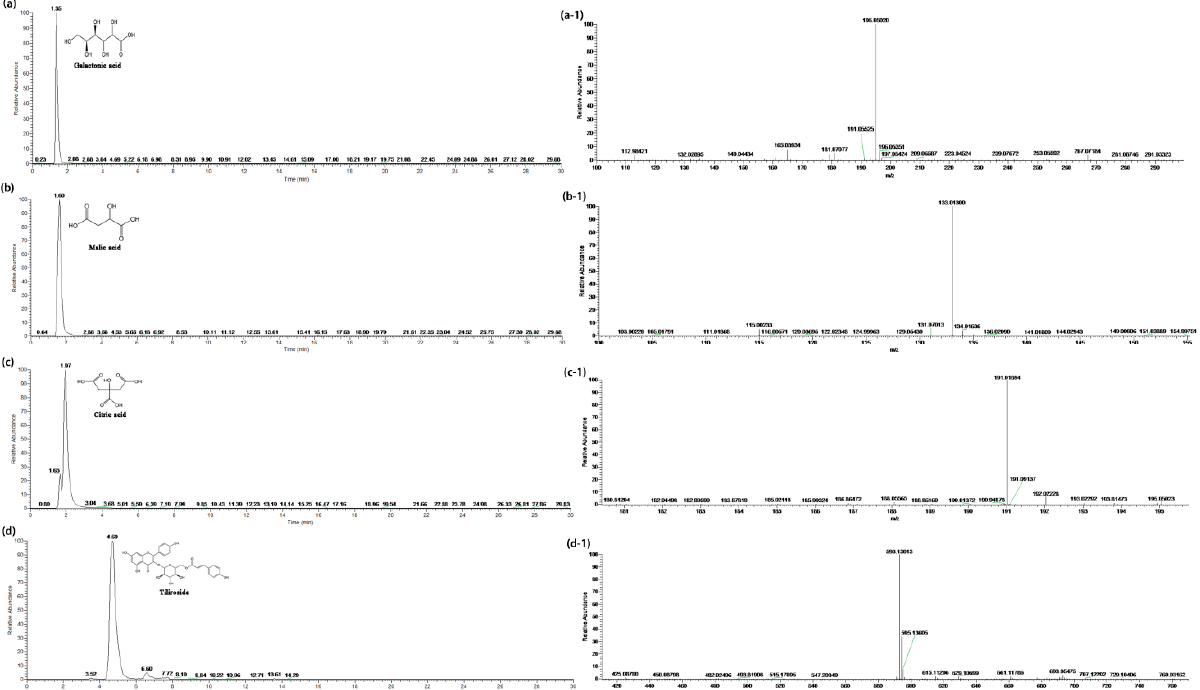
Figure 5. Identification of 14 kinds of compounds from HBWG by UHPLC–PAD–MS/MS . ( a ) UPLC chromatogram of galactonic acid, ( a-1 ) MS for galactonic acid, ( b ) UPLC chromatogram of malic acid, ( b-1 ) MS for malic acid, ( c ) UPLC chromatogram of citric acid, ( c-1 ) MS for citric acid, ( d ) UPLC chromatogram of tiliroside, ( d-1 ) MS for tiliroside .